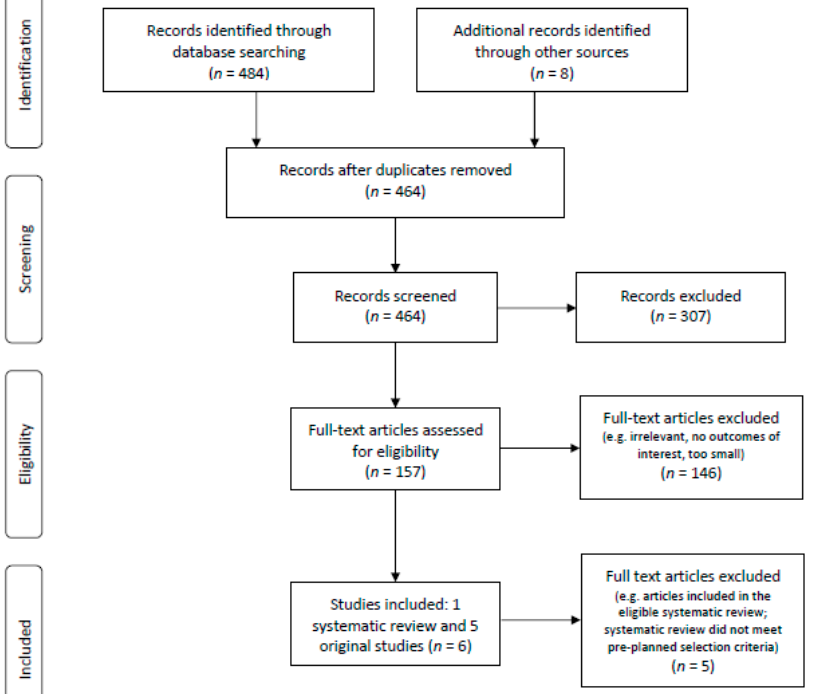
Figure 1. PRISMA flow diagram.